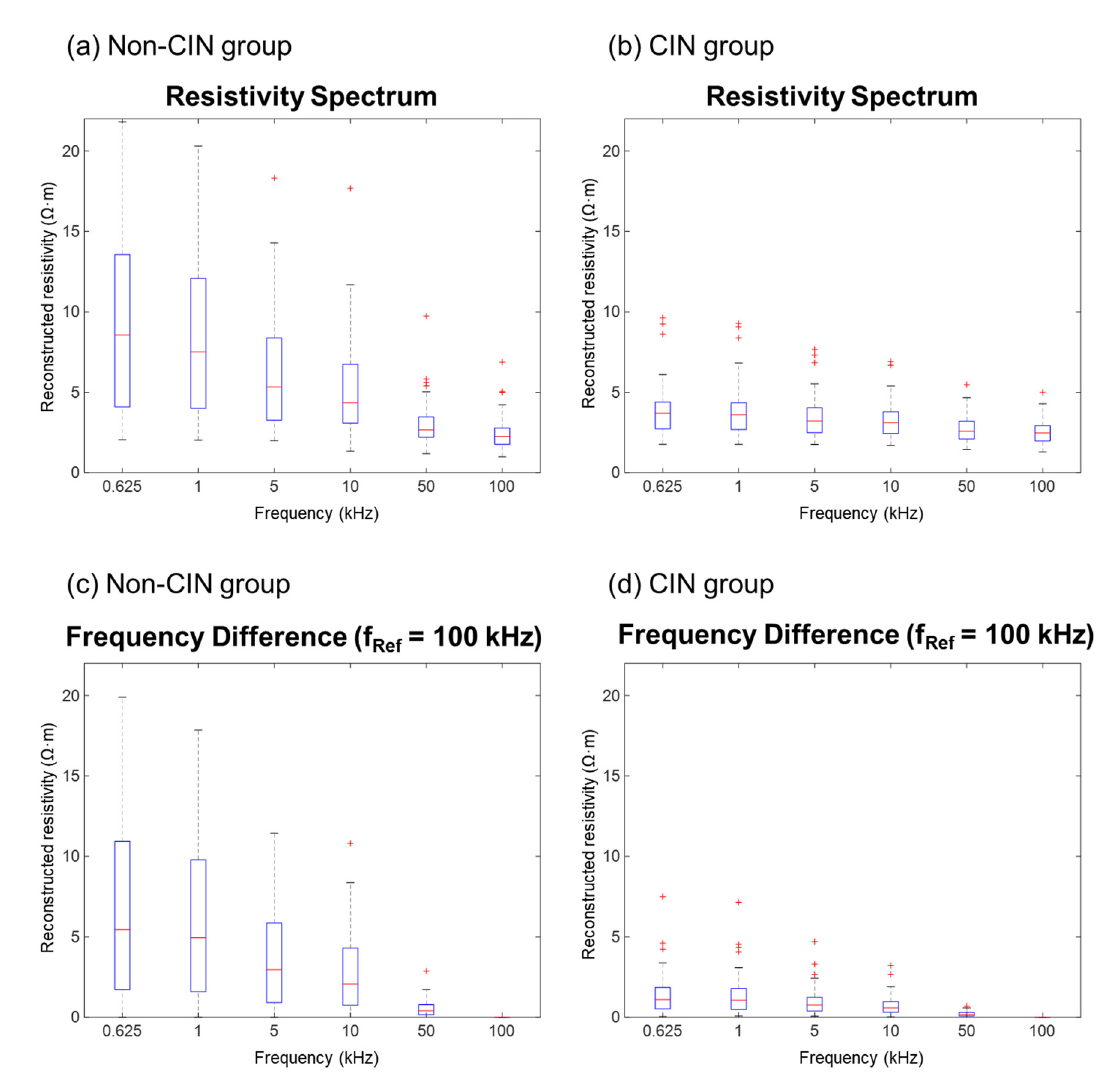
Figure 4. Resistivity and frequency difference resistivity spectra. ( a , b ) Resistivity as a function of frequency in cervical tissues from the ( a ) non-CIN and ( b ) CIN groups. ( c , d ) Difference in resistivity at each measured frequency relative to that at 100 kHz in cervical tissues from the ( c ) non-CIN and ( d ) CIN groups. To validate these findings, cutoff values were calculated using the receiver operating characteristic (ROC) curve. Patients with values above and below the estimated cutoff